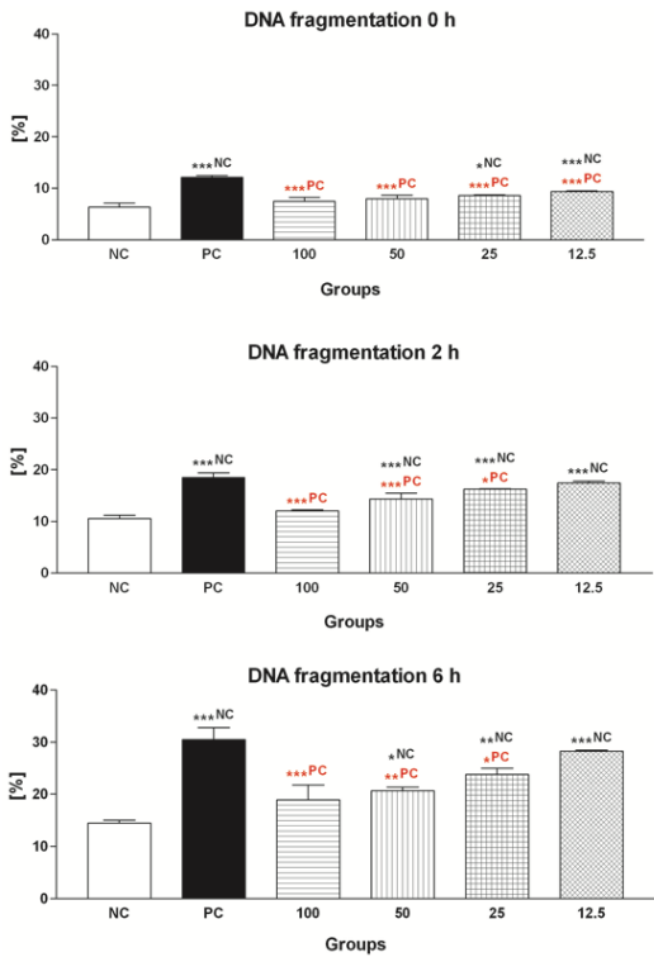
Figure 4. DNA fragmentation of bovine spermatozoa exposed to four doses of epicatechin (EPI; µ mol / L) in the presence of ferrous ascorbate (FeAA). The data were obtained from five independent experiments. * p < 0.05; ** p < 0.01; *** p < 0.001. NC—vs. negative control; PC—vs. positive control.